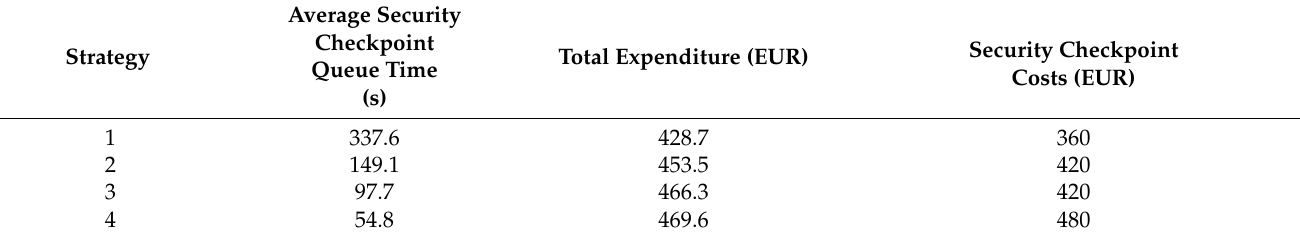
Table 2. Experiment 2 performance